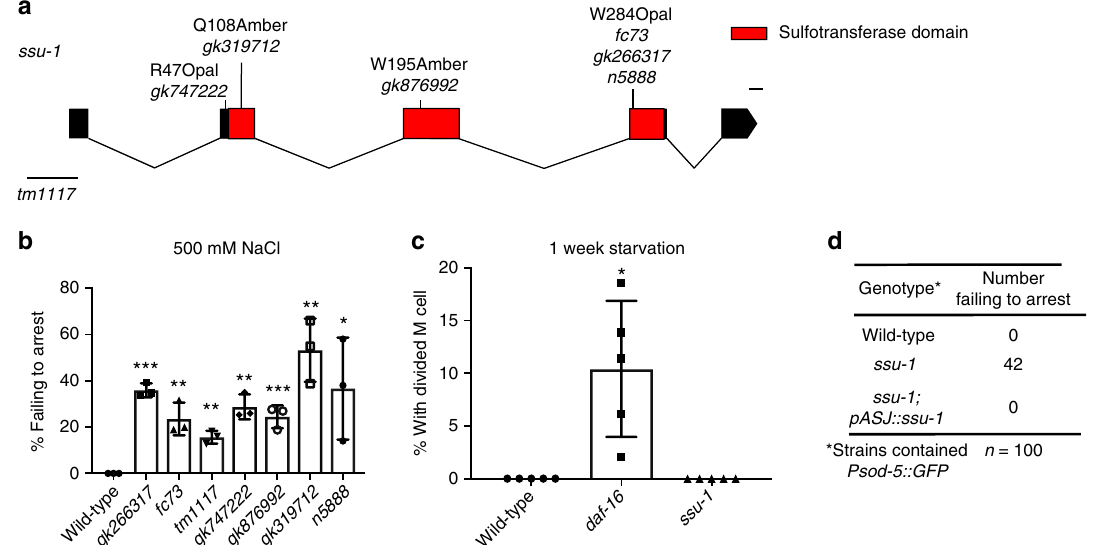
Fig. 1 The cytosolic sulfotransferase SSU-1 functions in the ASJ sensory neurons to regulate developmental arrest in response to osmotic stress. a Schematic of ssu-1 mutations that cause defects in developmental arrest in response to osmotic stress. Scale bar, 100 bp. Numbers represent amino acid numbers. b Percent of ssu-1 mutants failing to arrest development in response to 500 mM NaCl. n = 3 experiments, each with more than 100 animals. Error bars, s.d. c Percent of wild-type, daf-16(mu86) , and ssu-1(fc73 ) animals with a divided M cell after 1 week of starvation. Animals contained ayIs7 [hlh-8::GFP fusion + dpy-20( + )] to facilitate M-cell identi fi cation. n > 200 animals. Error bars, s.e.m. d Number of wild-type, ssu-1(fc73) , and ssu-1(fc73); ssu-1( + ) animals failing to arrest development in response to osmotic stress. The trx-1 promoter was used to drive ASJ cell-speci fi c expression of ssu-1 . Animals also contained wuIs57 [pPD95.77 Psod-5::GFP, rol-6(su1006)] , which drives GFP expression in response to osmotic stress. n = 100 animals. * p < 0.05, ** p < 0.01, *** p < 0.001. Two-tailed t -test. Source data are provided as a Source Data fi